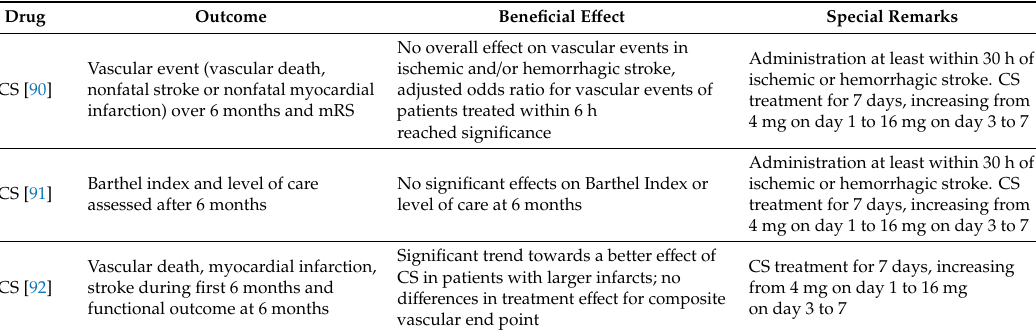
Table 2. Tabular listing of di ff erent clinical studies showing various e ff ects of Sartan administration (Abbreviations: Candesartan (CS); hours (h); losartan (LS); milligram (mg); minutes (min); µ